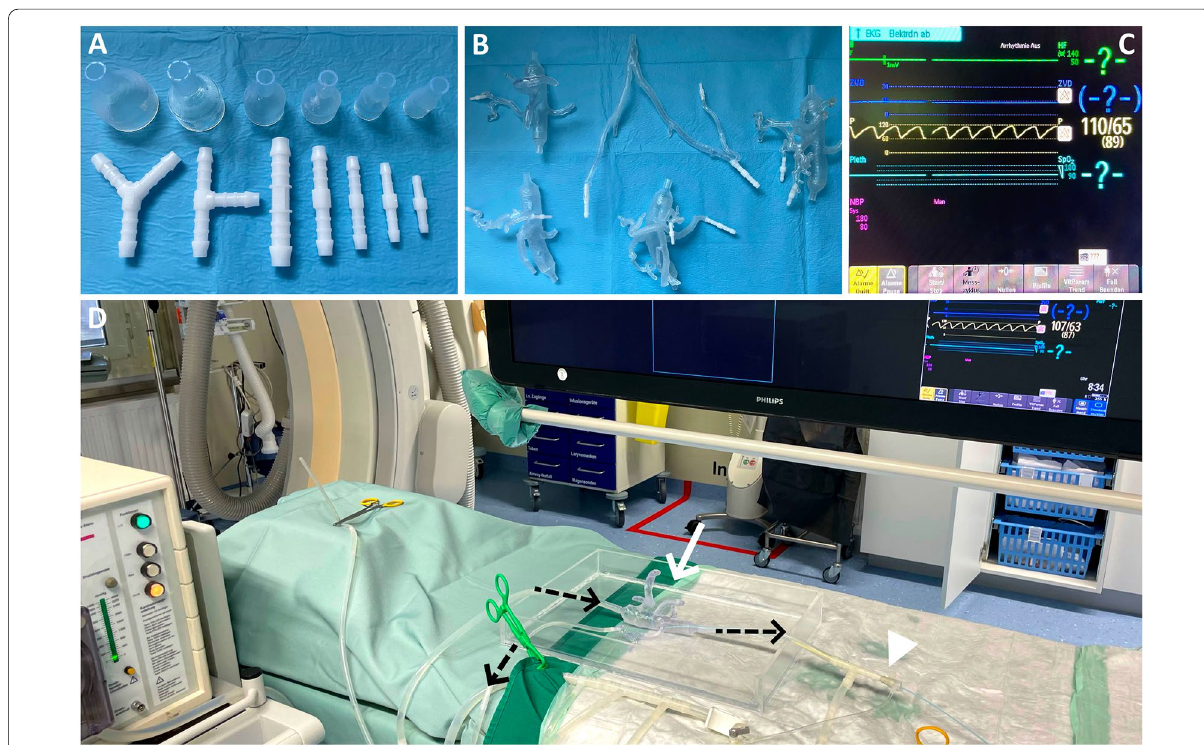
Fig. 2 Connection system and pressure measurements. A Straight, Y- and T-shaped tube connectors (white) and the solid 3D printed funnel-shaped connectors in different dimensions. B A set of vascular models with chemically bonded connectors. C Physiological arterial pressure gradients of 110–80 mmHg were established in the 3D printed vascular models using the peristaltic pump. D Intravascular pressure measurements of the adaptable endovascular simulation system in the angiography suite. White arrow: 3D printed vascular model with introduced catheter.